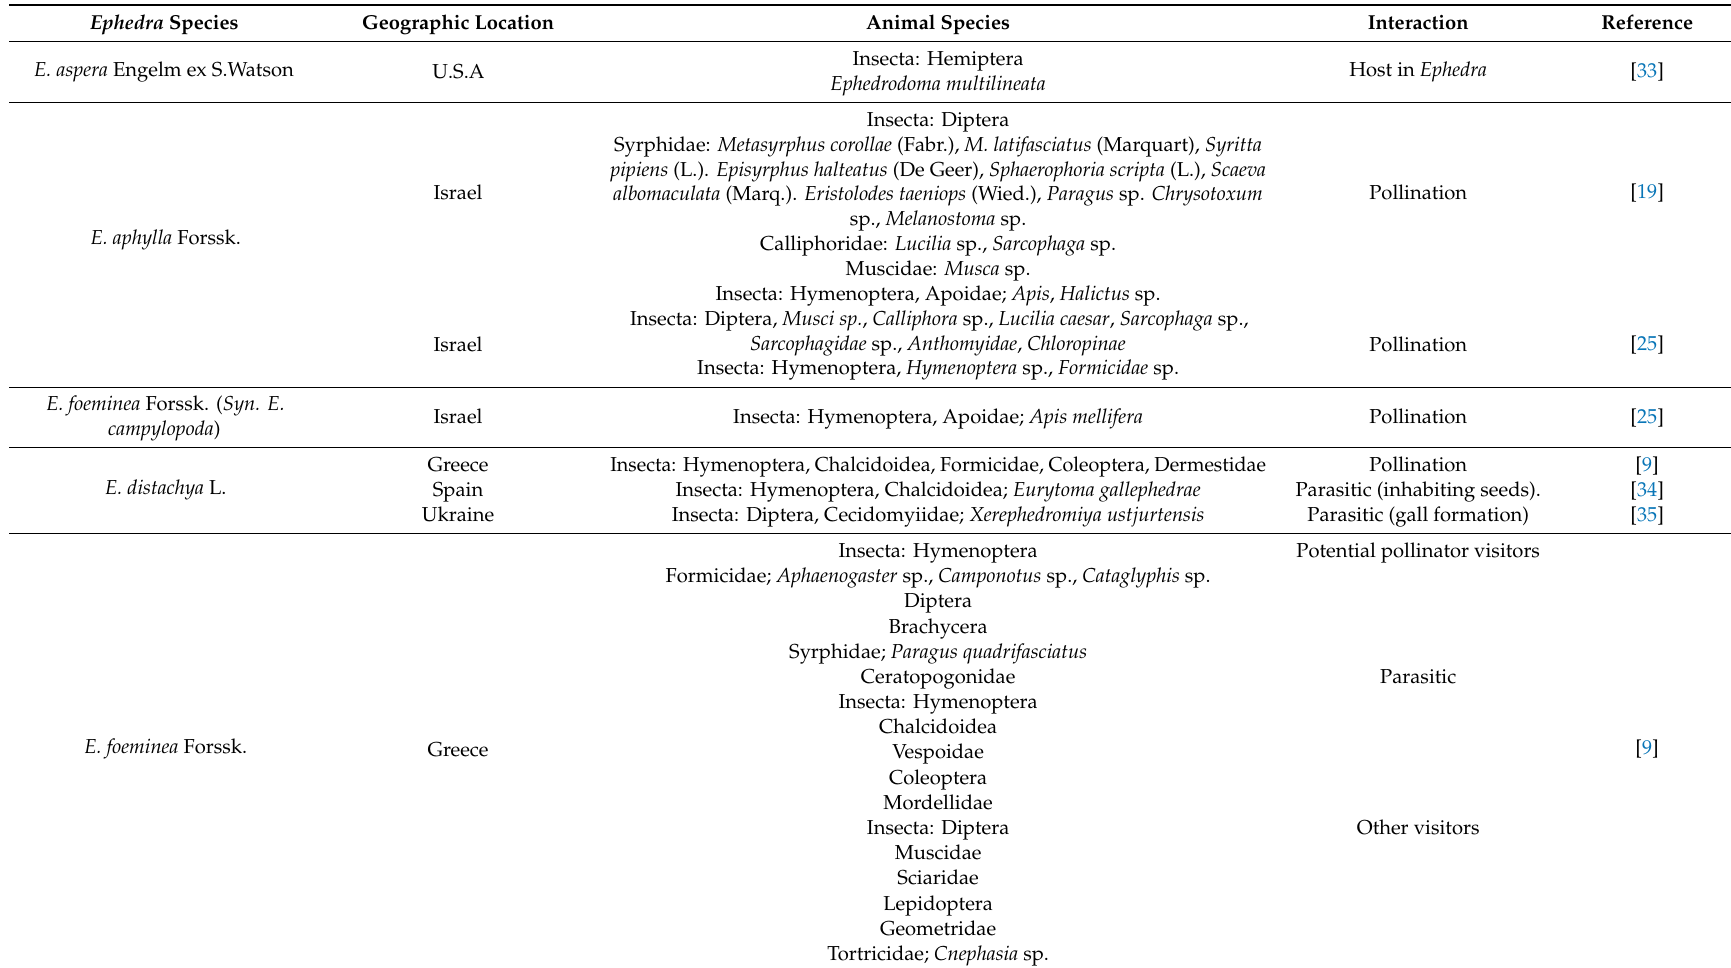
Table 2. Animal species interacting with Ephedra